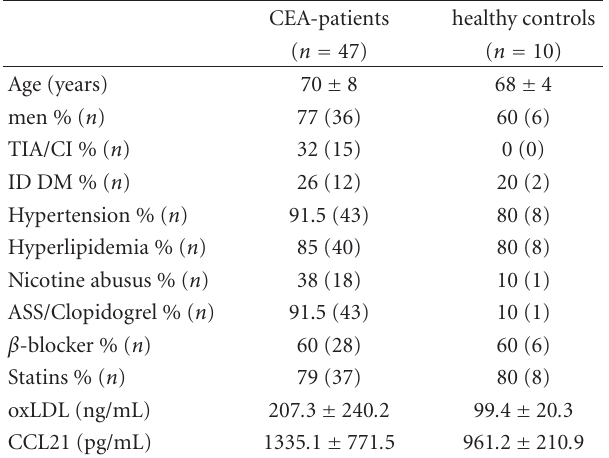
Table 1: Clinical characteristics of the patients and controls. Clin- ical characteristics including age, sex, cardiovascular risk factors, relevant medication, oxLDL and CCL21 of patients who received CEA and healthy controls without clinical history of manifest